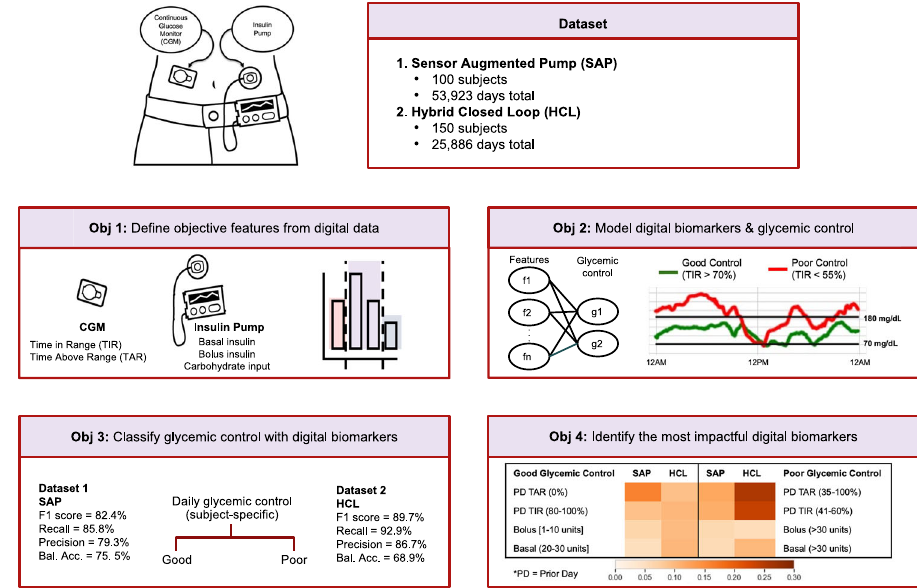
Fig. 1 Research overview. This study leverages over 79,000 days of CGM and insulin pump data from 250 subjects for four objectives: 1) de fi ne objective features from digital data, 2) model digital biomarkers and glycemic control, 3) classify glycemic control with digital biomarkers, 4) identify the most impactful digital biomarkers associated with good and poor glycemic control and consistent across two distinct datasets, i.e., sensor augmented pump (SAP) and hybrid closed loop